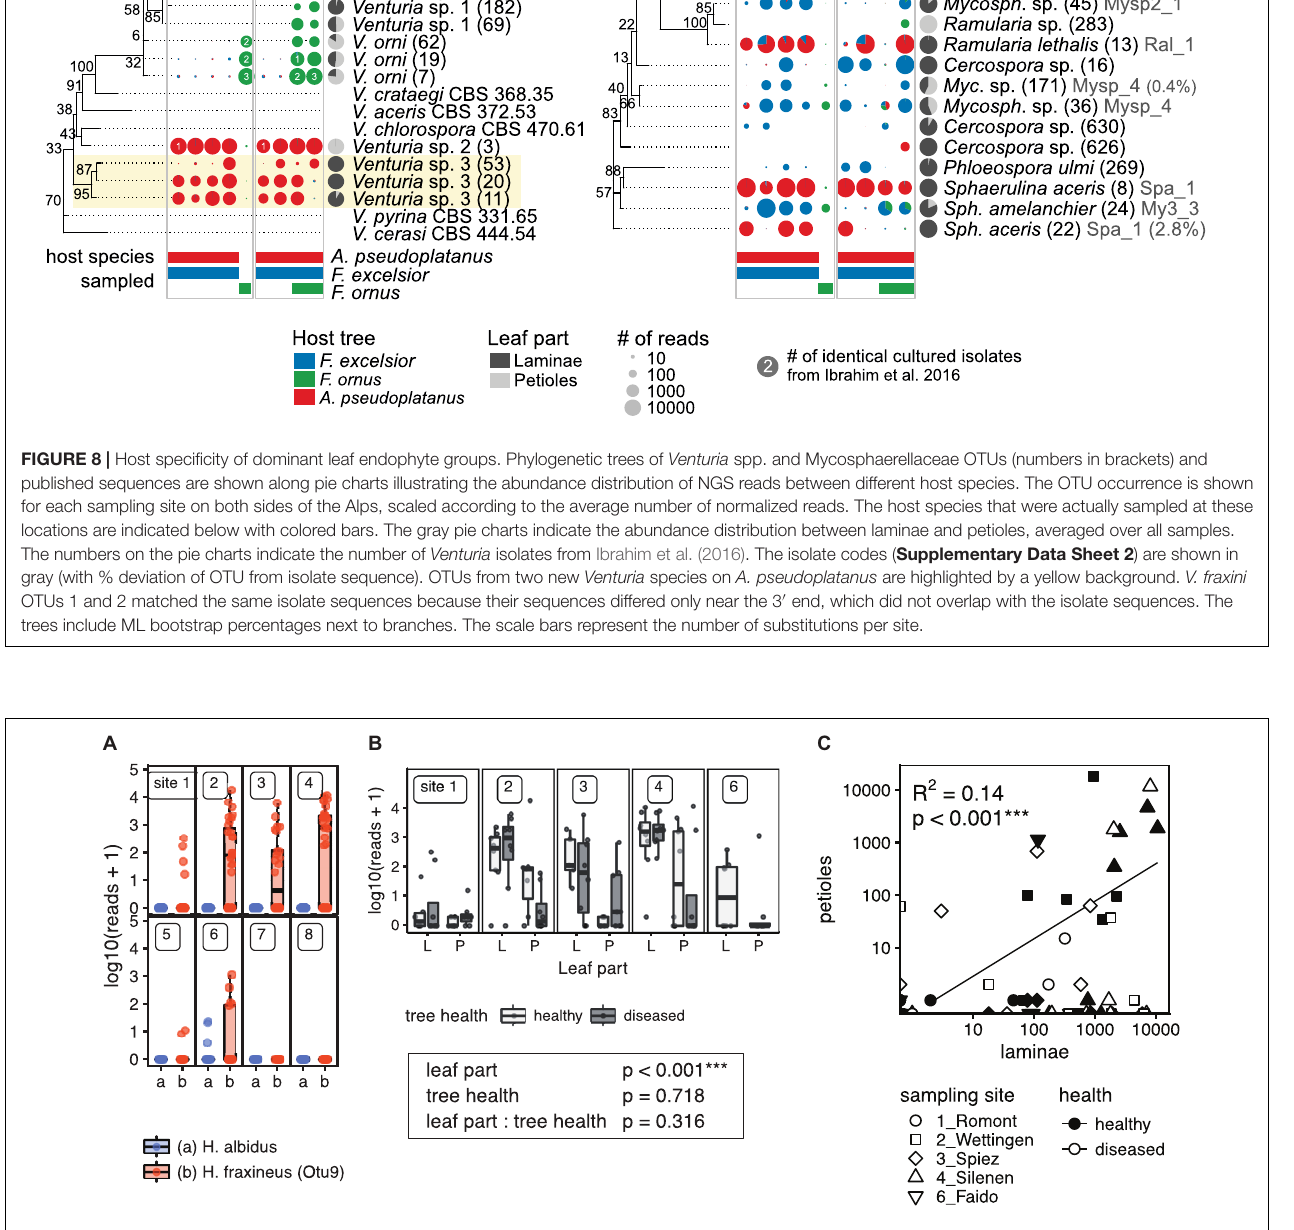
FIGURE 9 | Detection of the ash dieback pathogen H. fraxineus and the closely related native H. albidus in European-ash leaves by NGS sequencing. (A) Distribution of H. fraxineus and H. albidus across the different sampling sites. Scaled and log transformed read counts are shown as boxplots overlaid with individual sample points. Potentially misassigned rare H. fraxineus sequences (crosstalk) were removed. (B) Amount of H. fraxineus reads in lamina and petiole samples depending on the tree health. Only sampling sites where the pathogen was present are included. In addition, the p -values (Wald Chi-square test) of a linear mixed model for the effect of leaf part and tree health are shown. Three stars ( ∗∗∗ ) indicate a significant effect. (C) H. fraxineus content in laminae vs. petioles. The regression line is shown along with the adjusted R-squared and p -value of the linear model. ∗∗∗ Significant effect.